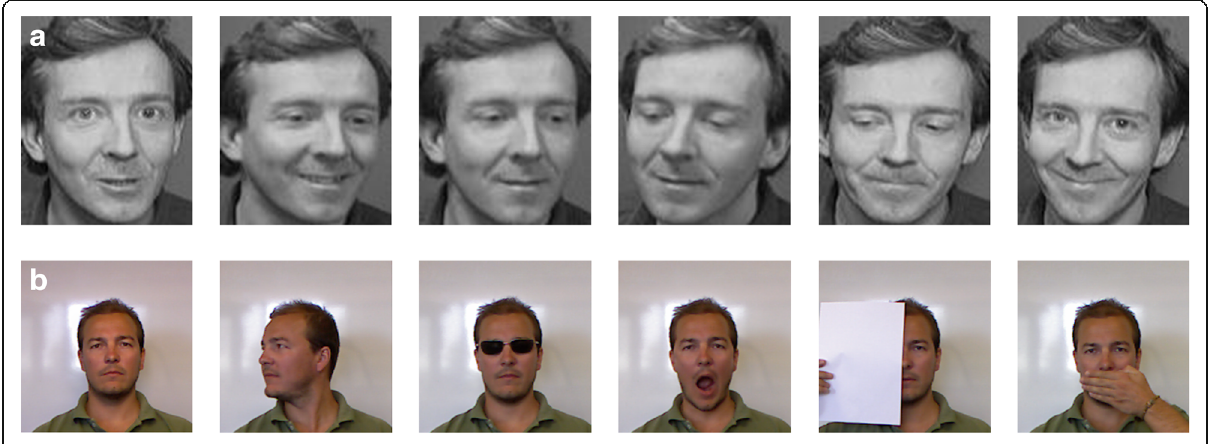
Fig. 3 Sample images from both datasets. a AT&T face dataset. b EURECOM Kinect Face Database